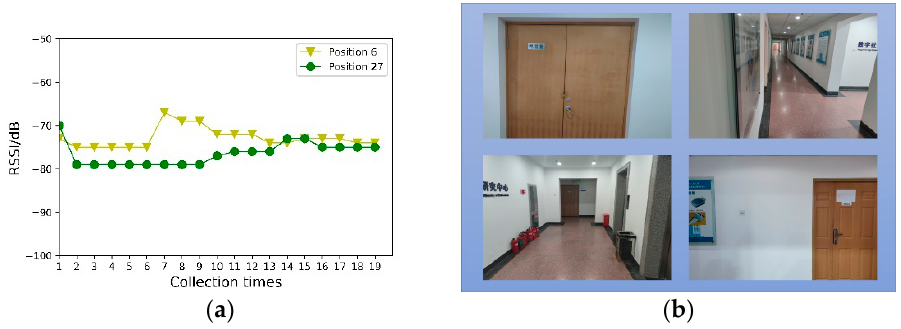
Figure 5. Comparison of Wi - Fi fingerprints and scene images in different locations: ( a ) The RSS value for the same AP, received at Positions 6 and 27. ( b ) The upper two pictures are the scene images at Position 6, and the lower two pictures are the scene images at Position 27.